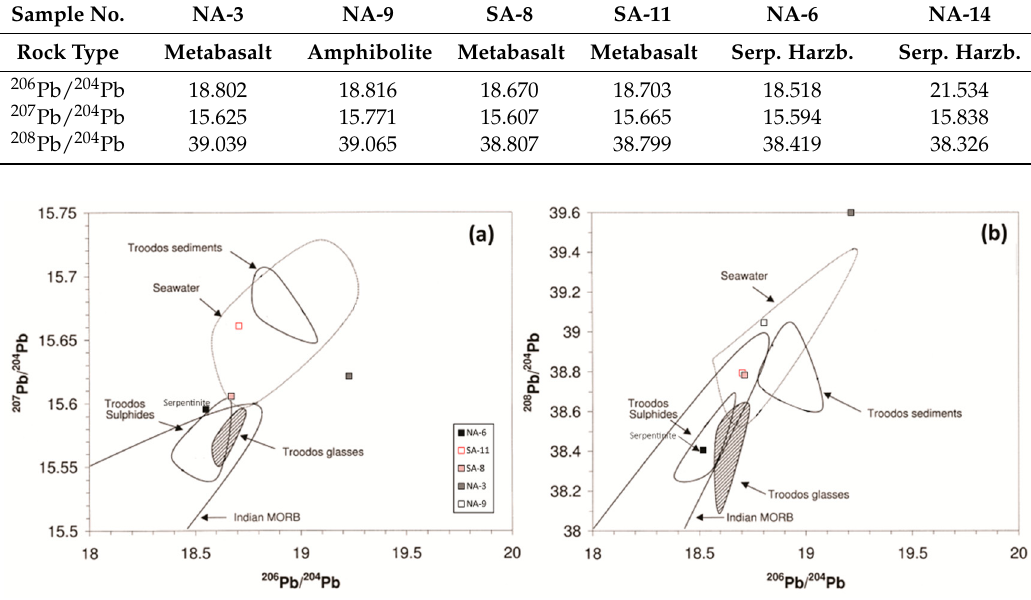
Figure 11. ( a ) 208 Pb/ 204 Pb versus 206 Pb/ 204 Pb and ( b ) 207 Pb/ 204 Pb versus 206 Pb/ 204 Pb plots showing the isotopic compositions of the Cycladic metabasites. Fields for Troodos glasses, sulfides, sediments, and seawater form [80] and references therein.